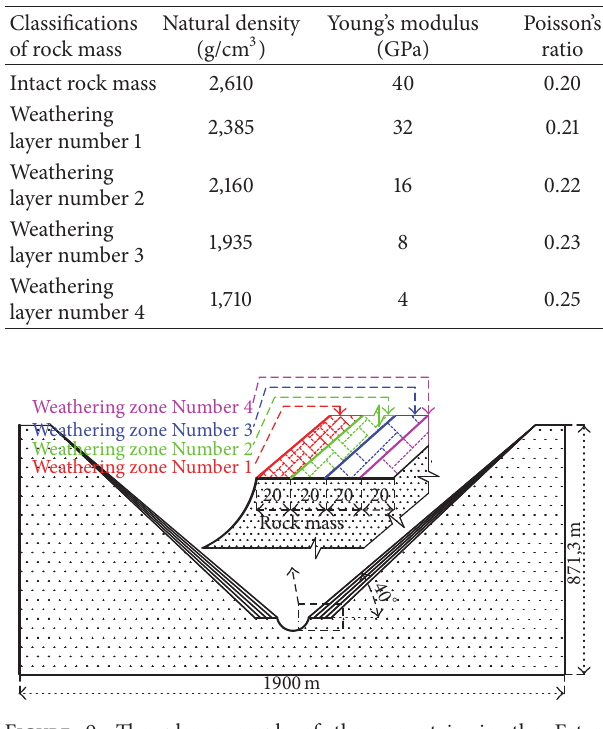
Figure 9: The planar graph of the mountain in the Ertan hydropower